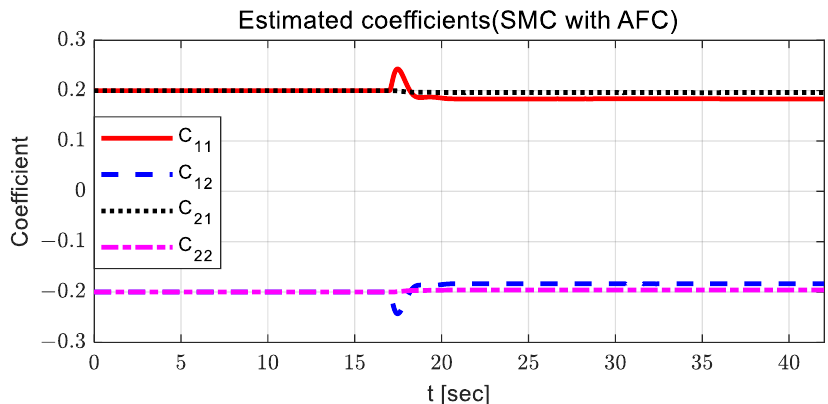
Figure 16. Results: estimated coefficients in the case of SMC with AFC for the lane change.